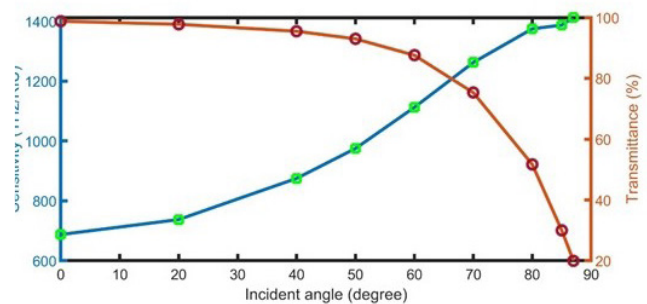
Figure 6. The effect of changing the incident angle on the sensitivity at d